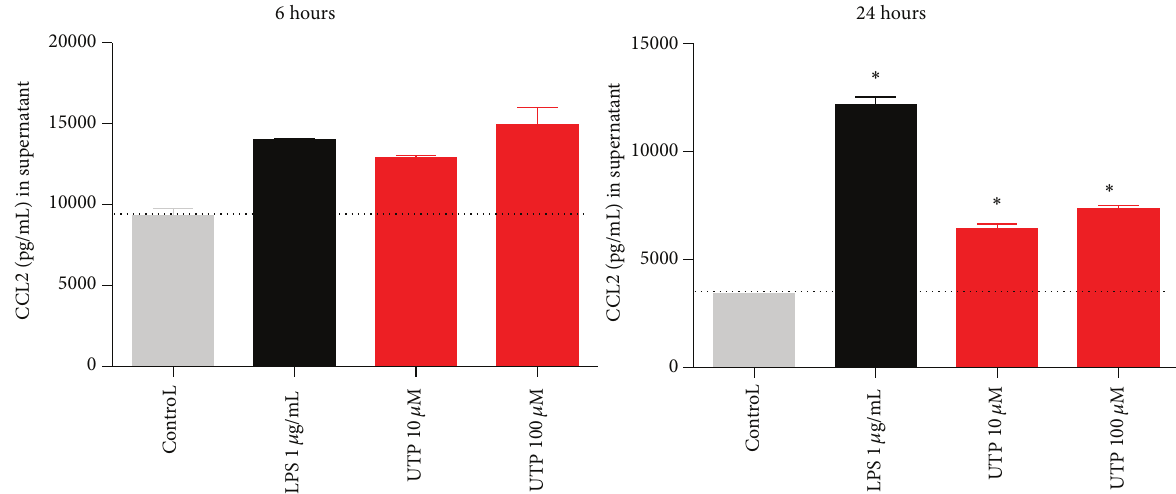
Figure 7: IFN/LPS differentiated THP-1 macrophages display increased CCL2 production to LPS or UTP. THP-1 cells were plated in RPMI media containing 10% serum and stimulated with IFN- 𝛾 and LPS for 48 hours. Media were removed and cells were challenged with either media alone (control), LPS (1 𝜇 g/mL), UTP (10 𝜇 M), or UTP (100 𝜇 M) for 4 hours. Mean raw data is plotted in pg/mL ± SEM. Standard curves were performed for each ELISA experiment with fits of 𝑟 > 0.95